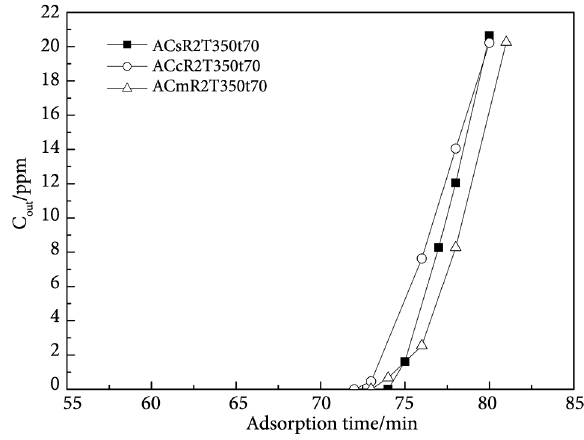
Figure 4. Adsorption time curves for different stalk carbon raw materials